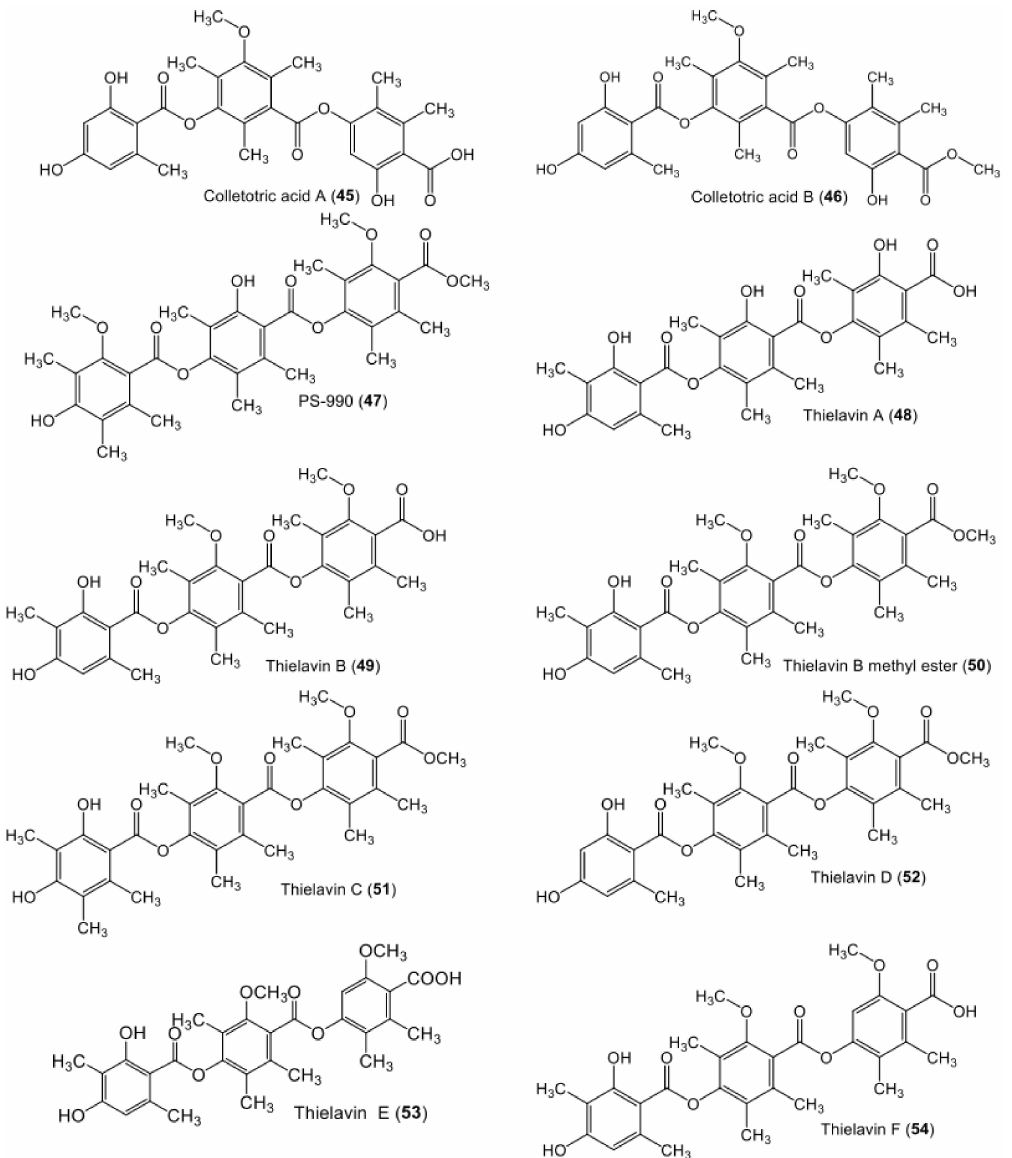
Figure 8. Chemical structures of tri-depsides 45 – 54 . Compound 45 , a new tridepside produced by Colletotrichum gloeosporioides and associ- ated with Artemisia mongolica , was tested in the disk diffusion assay for B. subtilis , S. aureus , S. lutea , Pseudomonas sp., C. albicans , A. niger , C. elegans , H. sativum , and T. rubrum . It exhib- ited antibacterial potential toward B. subtilis (MIC 25 µ g/mL), S. aureus (MIC 50 µ g/mL), and S. lutea (MIC 50 µ g/mL) in comparison to ampicillin (MIC values of 0.05, 0.5, and 0.01 µ g/mL, respectively) and an antifungal effect toward H. sativum , with an MIC value of 50 µ g/mL, relative to triadimefon (MIC value of 20 µ g/mL)